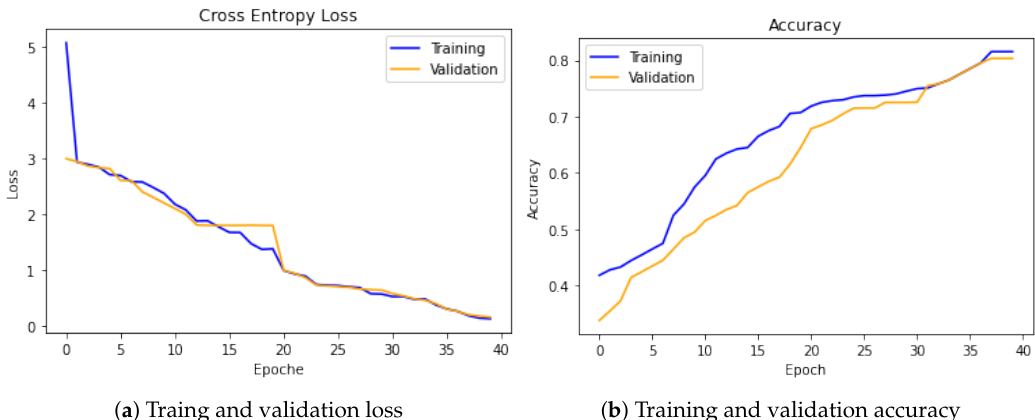
Figure 4. Cross-entropy loss and accuracy during the training and validation steps are shown in ( a , b ),